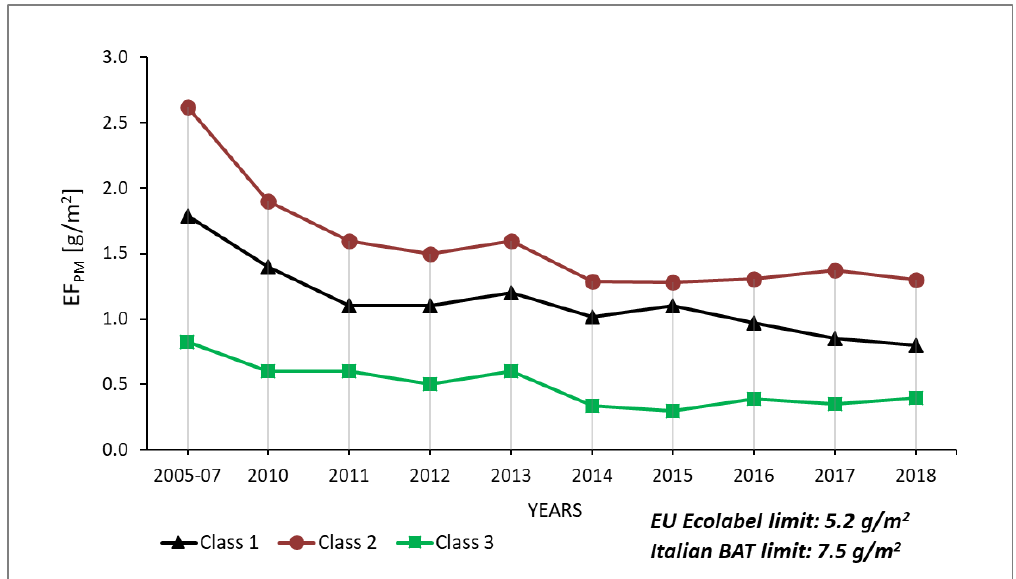
Figure 3. Trend for the emission factor of particulate matter, EF PM, for the three production classes. Appl. Sci. 2020 , 10 , x FOR PEER REVIEW